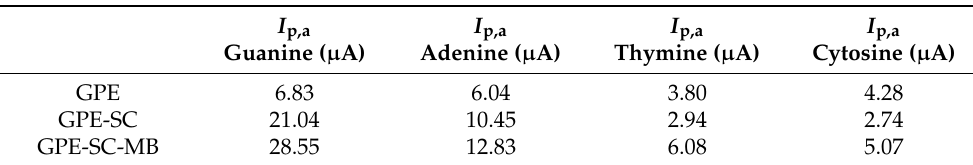
Table 1. A comparison of the anodic peak current values observed using the bare GPE, GPE-SC, and GPE-SC-MB for four DNA bases G (33.3 µ M), A (33.3 µ M), T (333.3 µ M) and C (333.3 µ M) in 0.2 M phosphate buffer (pH 7.0). I p,a